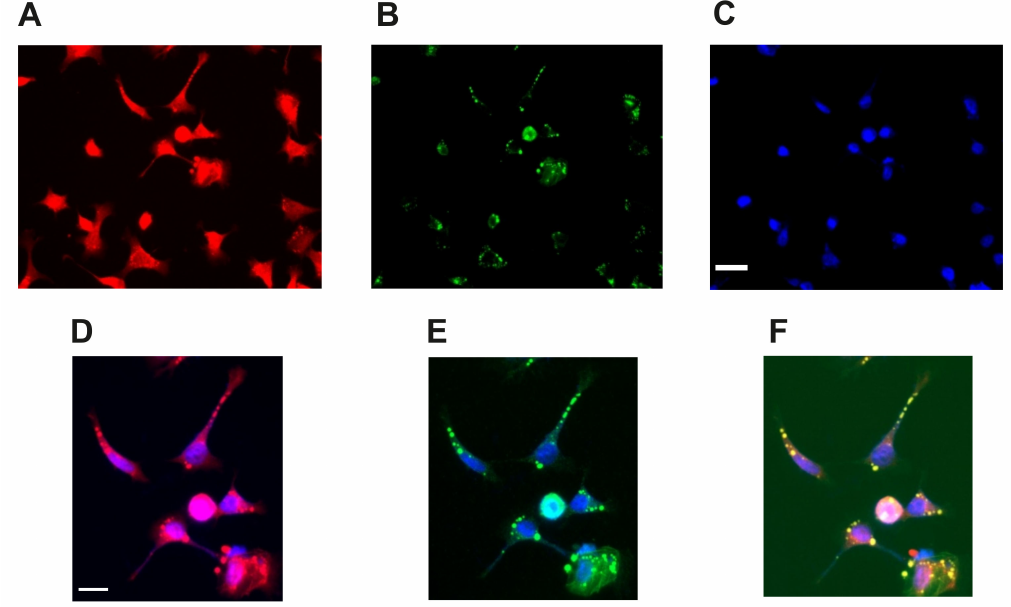
Figure 2. PP2Ac and pTau colocalize extranuclearin differentiated SHSY-5Y neurons. ( A ) Differentiated SHSY-5Y labelled with anti PP2A (red), ( B ) Same neurons labelled with anti-pTau (S202, green) and ( C ) labelled with nuclear stain DAPI (blue). ( D ) Merged image of PP2A and DAPI. ( E ) Merged image of pTau and DAPI and ( F ) Merged image of all three (yellow) highlighting co-localization of PP2A and pTau as extranuclear. Scale bar image ( C ) 50 µ m and image ( D ) 20 µ